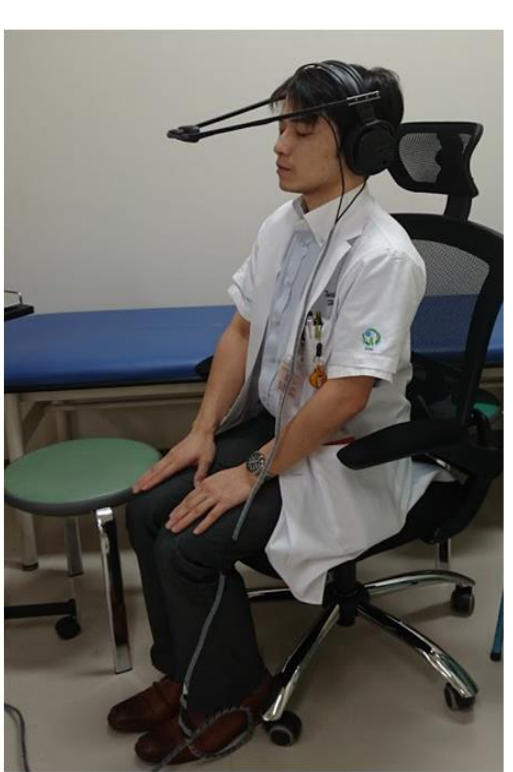
Figure 1. Position in which subjects listened to questions related to lower back pain and general questions unrelated to lower back pain using headphones. This subject consented to the use of the image.